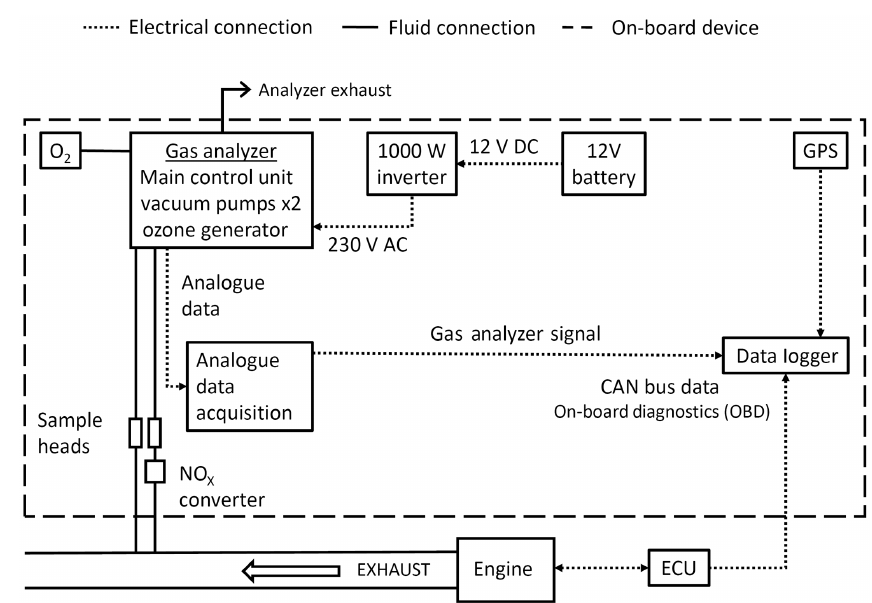
Figure 1. Schematic showing the layout of the various components required for the on-board fast gas analyzer measurements. Dashed lines represent electrical connections, and fluid connections are represented by solid